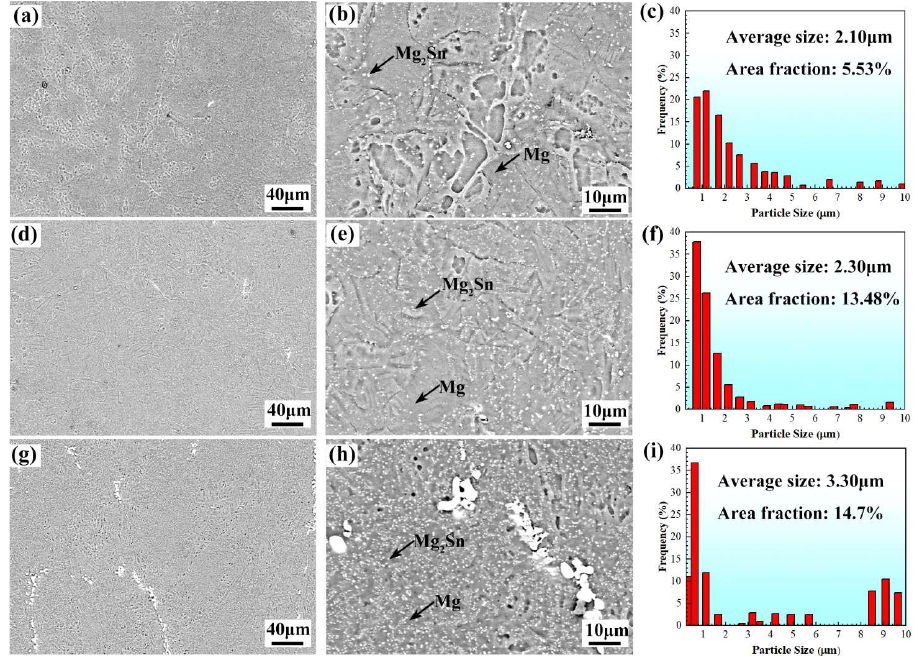
Figure 5. SEM images of ( a , b ) R30 alloy; ( d , e ) R50 alloy; and ( g , h ) R70 alloy. Statics of Mg 2 Sn phase in ( c ) R30 alloy; ( f ) R50 alloy; and ( i ) R70 alloy.